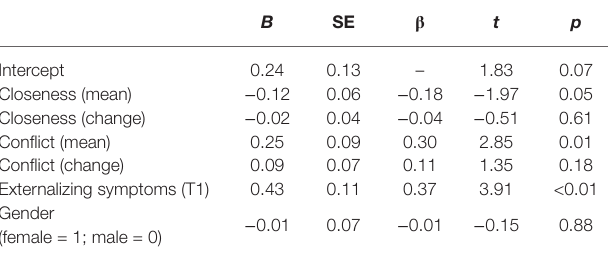
TABLE 4 | From primary to middle school: T2 externalizing symptoms on student-teacher relationship scale variables ( N = 97; R 2 = 0.63). B SE β